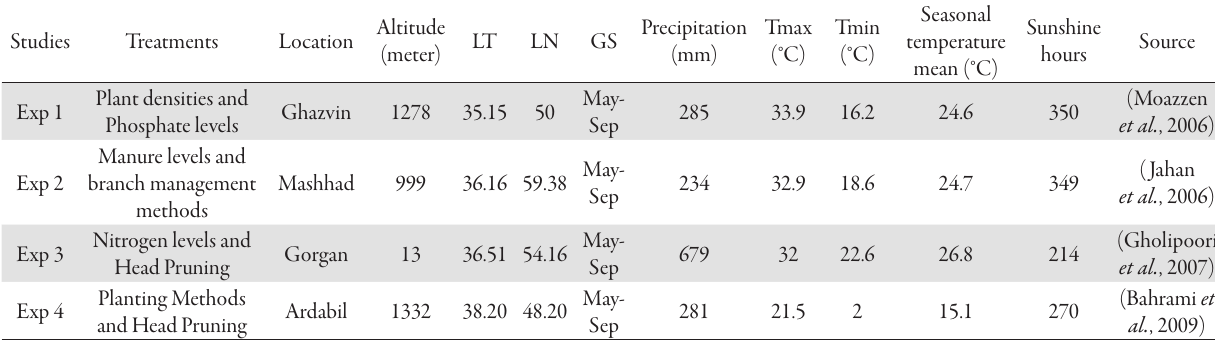
Tab. 1. Field experiments data of summer squash studies in Iran